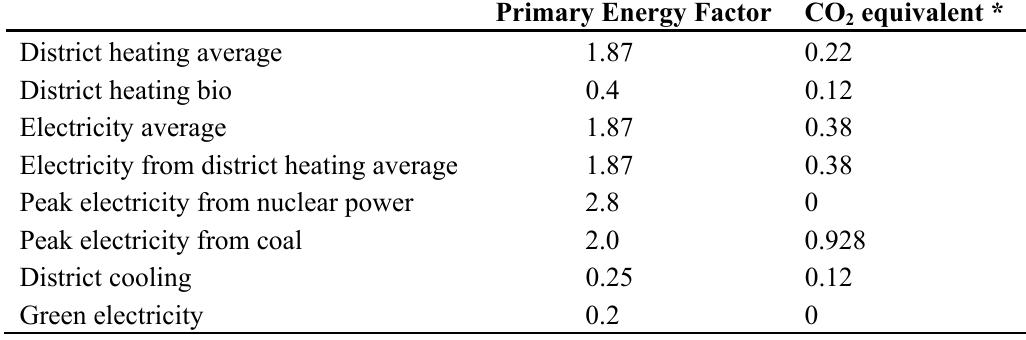
equivalent emissions 2